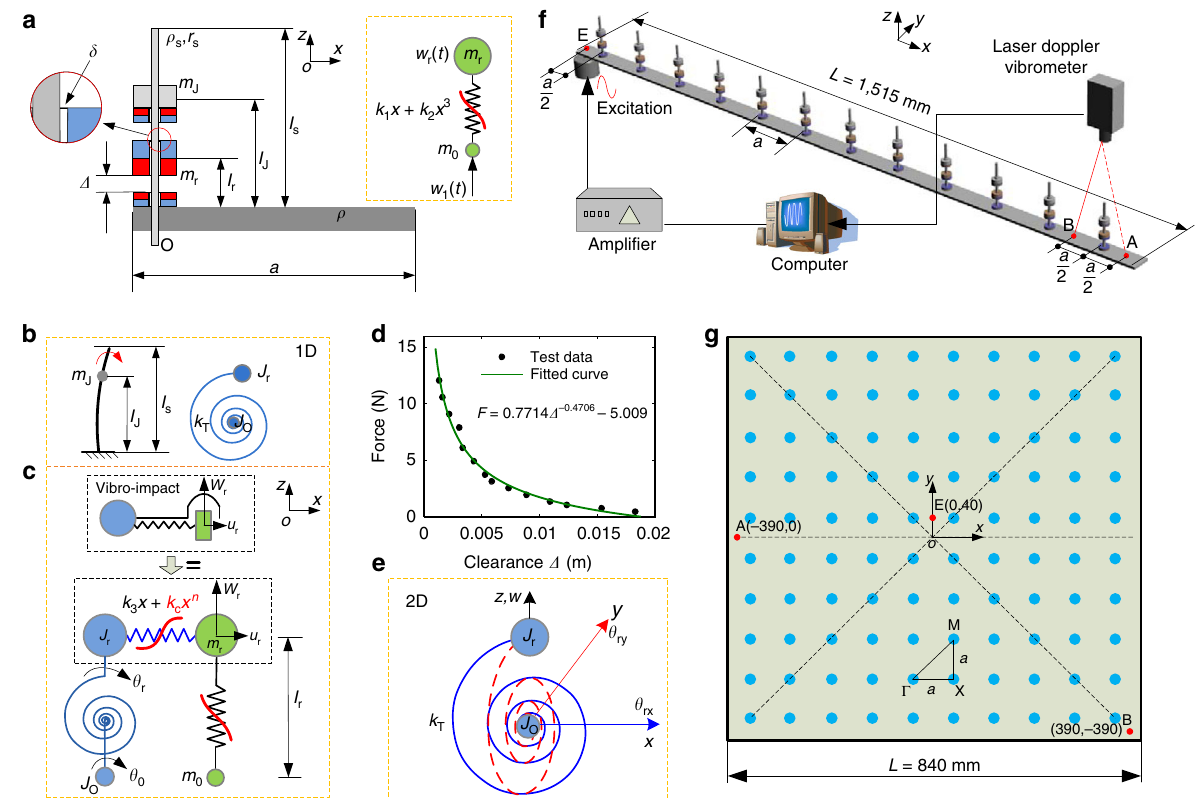
Fig. 2 Con fi gurations of the NAM beam and plate. a Lateral view of the meta-cell with its parameters; the blue and red parts represent three magnets. The gray rectangle with length a is the principle beam/plate, and the columniform strut with length l s is used to support the magnets. There is a clearance δ between the strut and the magnet m r . The plot in the dashed box is the equivalent two-degrees-of-freedom (2DoF) Duf fi ng model of the transverse motion of m r . b Equivalent torsional motion of the whole attachment in the xz plane. c Whole equivalent coupling model for the attachment in NAM beam. d Repulsive force – clearance Δ relation of a pair of magnets. e Torsional system in 3D space for the 2D NAM plate. f The NAM beam consists of 12 periodic cells and the experimental apparatus. g The 2D NAM plate consisting of a square thin plate and 10 × 10 periodic attachments represented by blue points. In f , g , three red points, A, B and E, denote the measurement points, and E is also the excitation point. The positions of these points on the beam are labeled in f . For the plate, taking the center point of the square plate as the origin, the coordinates ( x , y ) of these points are